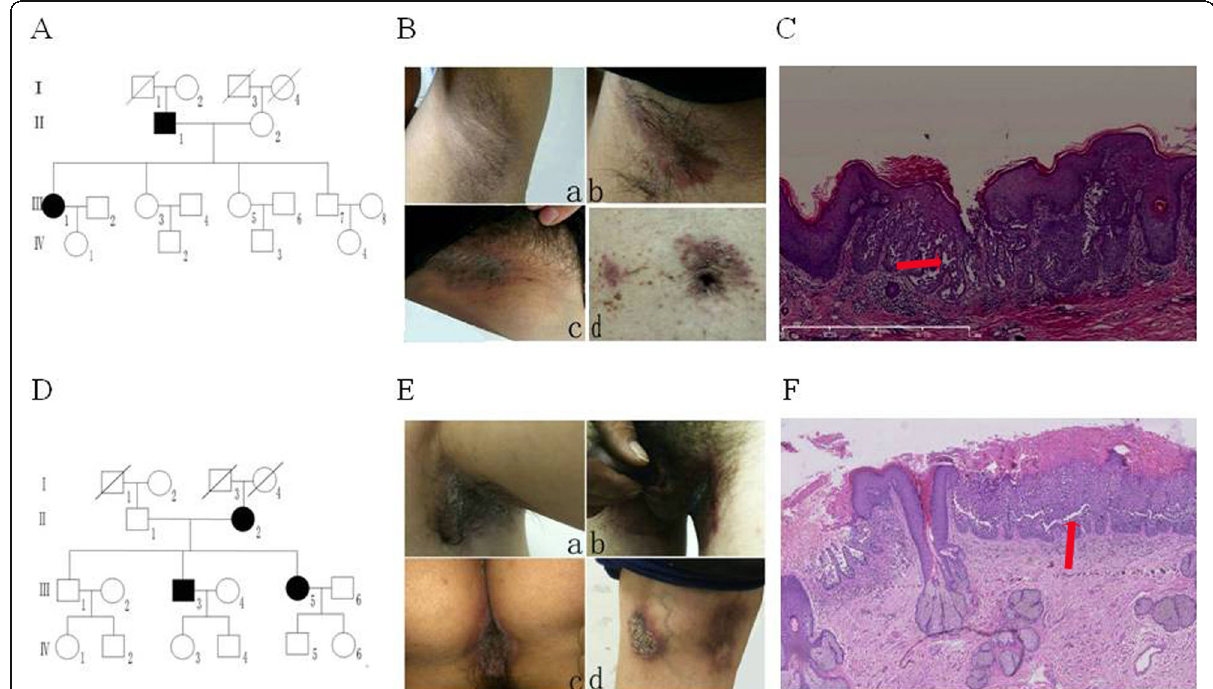
Fig. 1 Pedigree analysis and clinical data of pedigree I and II. (A) Pedigree chart of pedigree I. (B) Clinical manifestations of the proband in pedigree I. (C) Histopathological examination of typical skin lesion for the proband in pedigree I (5×)(Arrow shows acanthosis). (D) Pedigree chart of pedigree II. (E) Clinical manifestations of the proband in pedigree II. (F) Histopathological examination of typical skin lesion for the proband in pedigree II (5×) (Arrow shows